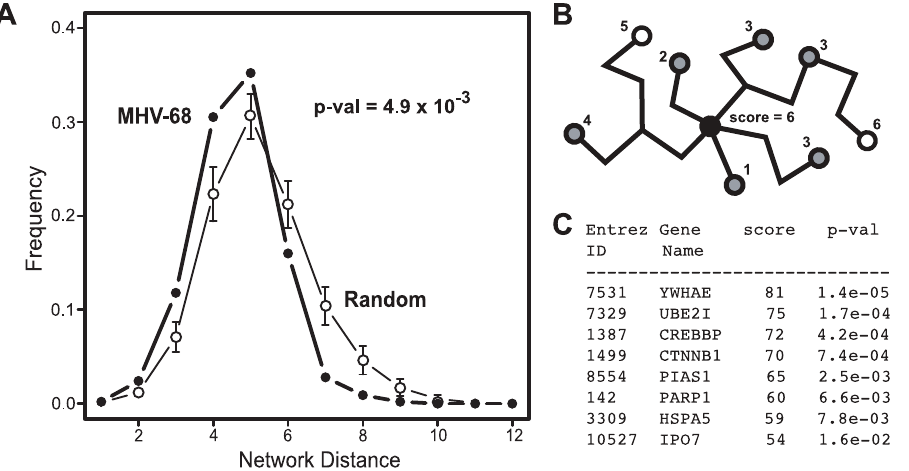
Figure 4. Network context of cellular proteins that interacted with MHV-68 proteins. (A) Distribution of the network distances between cellular proteins that interacted with MHV-68 proteins. The distances between cellular proteins that interacted with MHV-68 proteins in the reference cellular protein interaction network (i.e., the number of protein-protein interactions that must be passed through to connect a pair of proteins) were calculated and plotted. Closed circles (thick line) represent the observed distribution of distances between the MHV-68-interacting proteins. Bars (thin line) show the average distance distribution from an equivalent number of randomly selected cellular proteins. (B) Calculation of a network neighborhood-based priority score. The black circle indicates a cellular protein that interacted with an MHV-68 protein and that served as the starting point in this example. Gray circles indicate other human proteins that interacted with MHV-68 proteins. White circles represent human proteins that did not interact with MHV-68. The priority score was calculated by counting the cellular proteins that interacted with MHV-68 proteins within a distance of four interactions. (C) The priority scores of the top ranked cellular proteins identified in the Y2H screen.